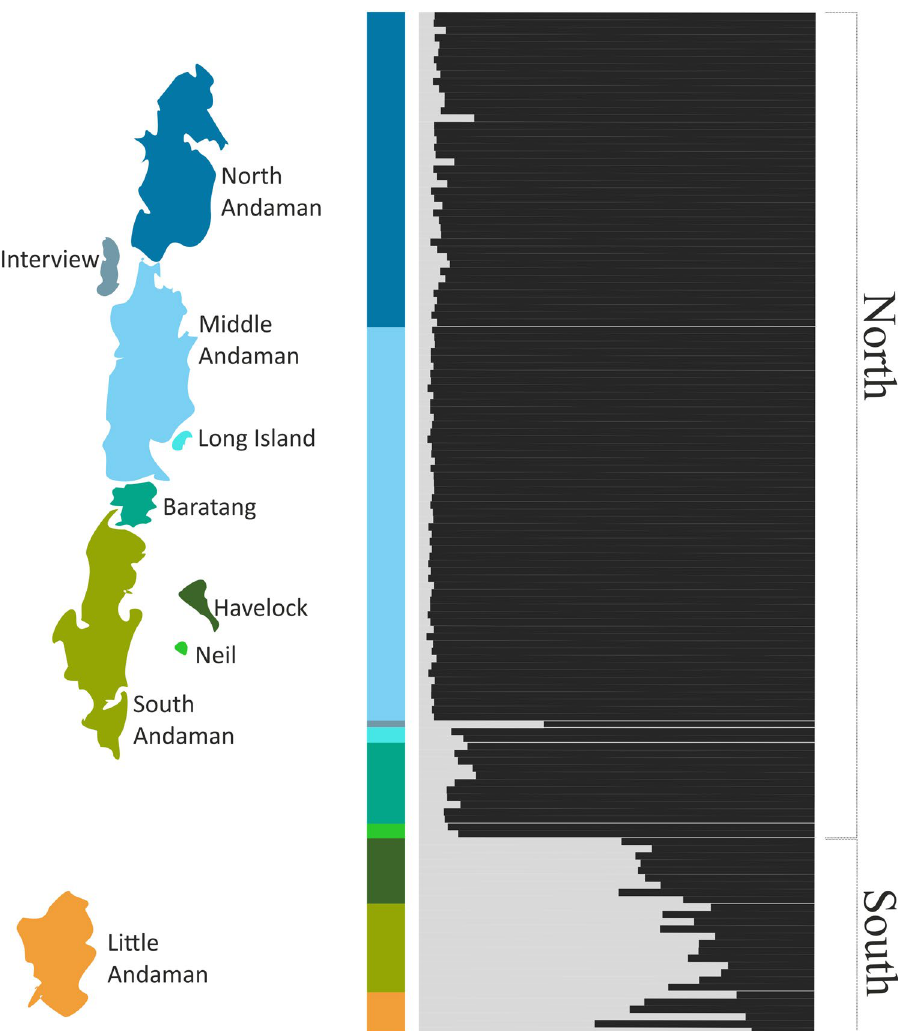
Figure 3. Population clusters identified using microsatellite alleles of the Andaman day gecko ( Phelsuma andamanensis ) (K = 2). Individuals are colour coded based on the island of their origin. North and South clusters are identified on the right. Composite figure produced in CorelDraw Home & Student, X7 (https ://www. corel draw.com), map created for graphical representation only and is not to be